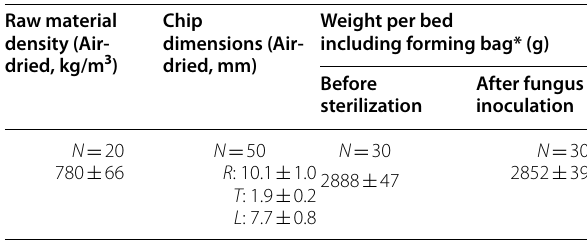
N the number of samples, R , T , L ; radial, tangential, and longitudinal directions,